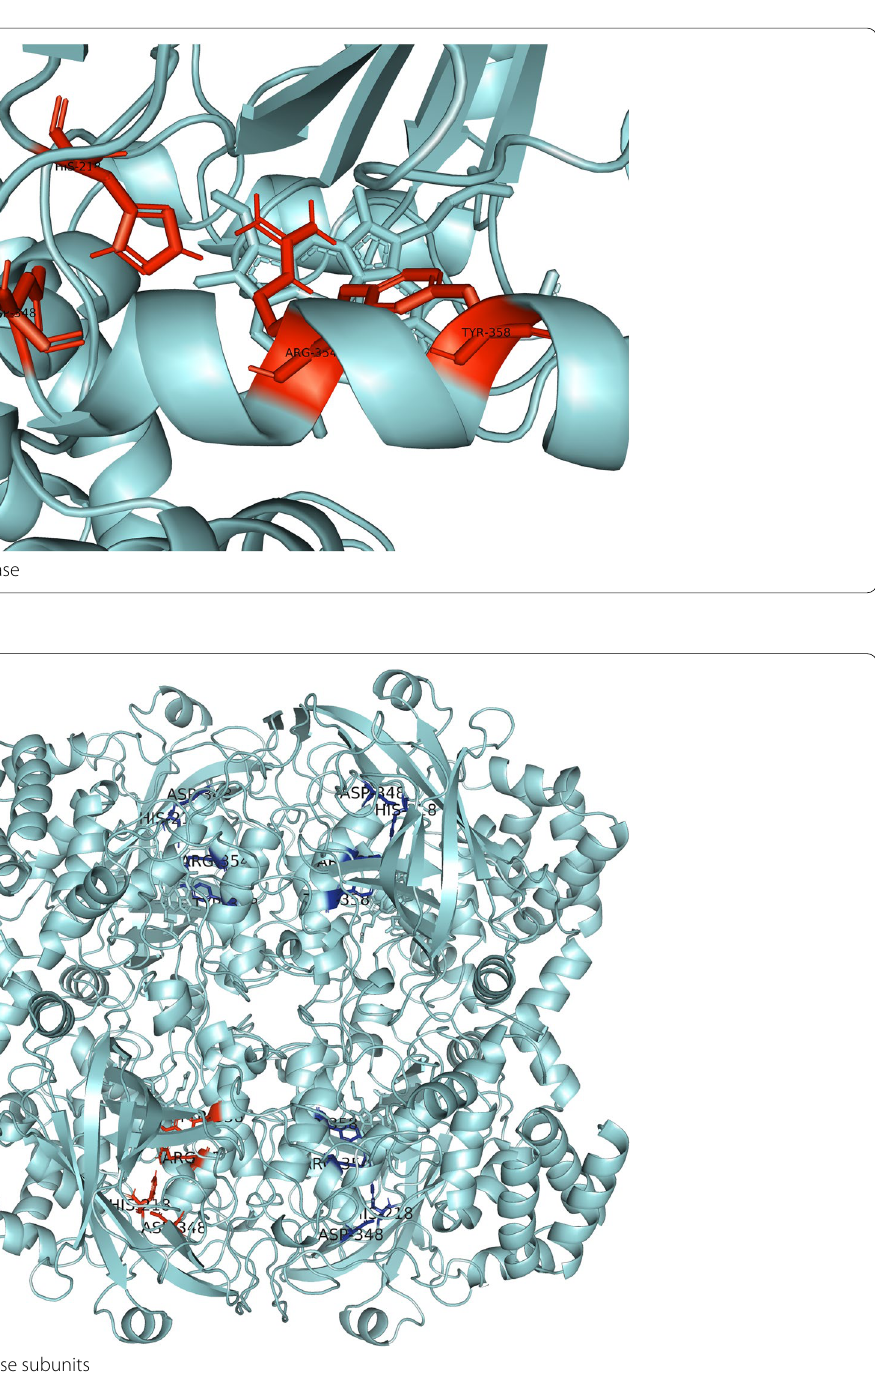
column shows the distance of other results from the first, best result. RMSD (root-mean-standard-deviation) is the most commonly used unit of measurement for the quantitative determination of similarities between atomic coordinates and is expressed in ångström (Å) [32].